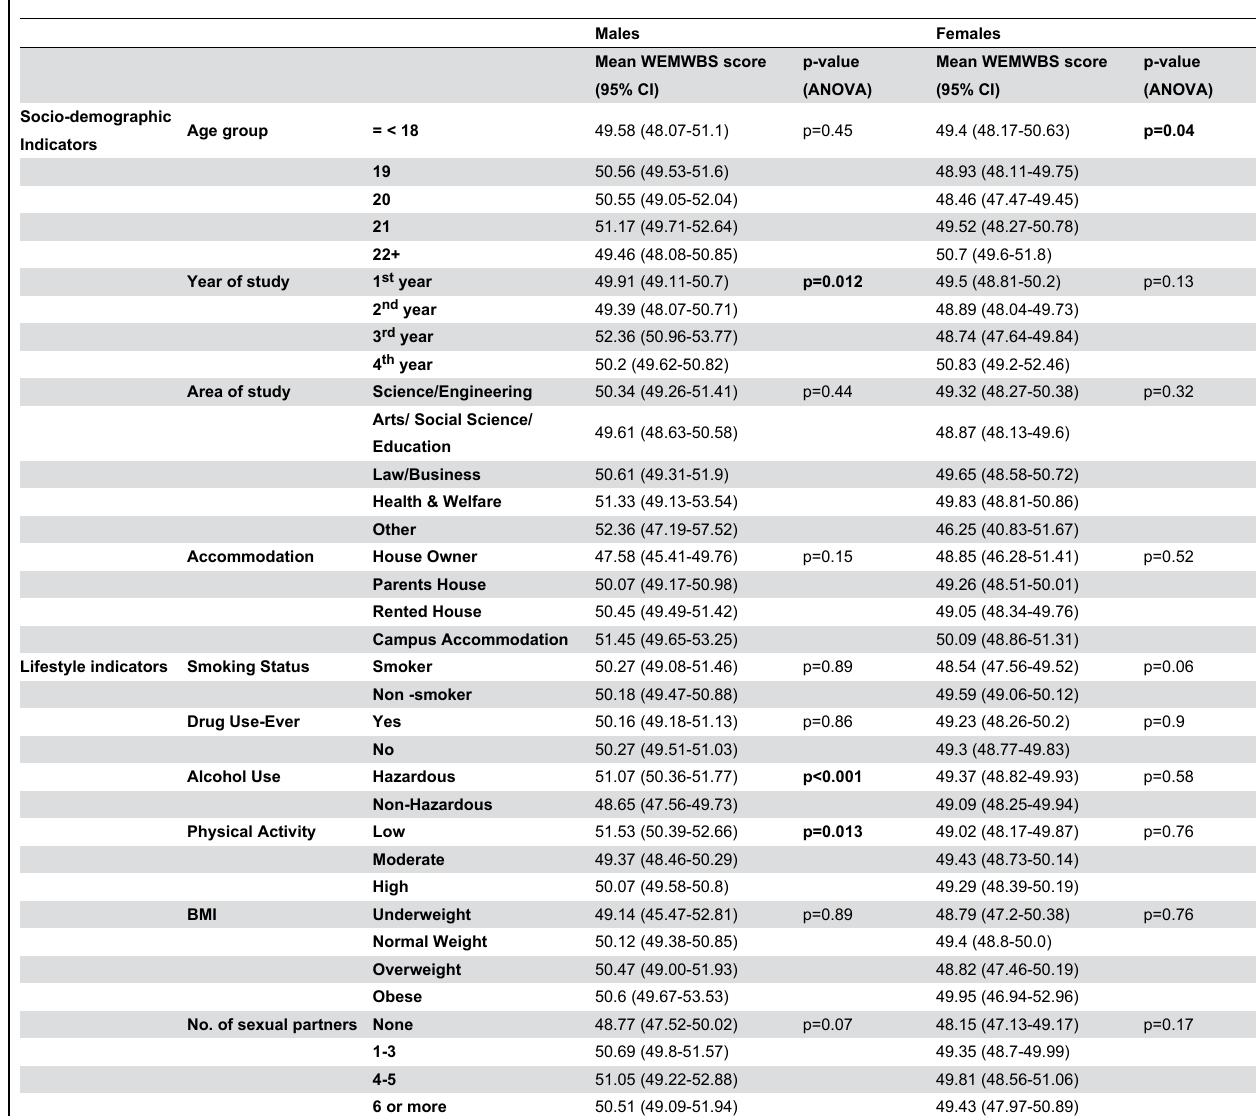
Table 2. WEMWBS scores by Gender & Socio-demographic